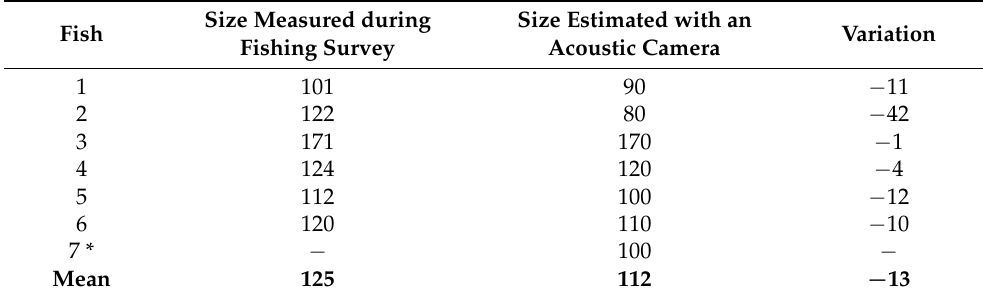
Table 3. Real and estimated total length with variation (cm) of the seven fish observed during simultaneous acoustic camera and fishing campaigns. Size Measured during Size Estimated with an Fish Fishing Survey Acoustic Camera